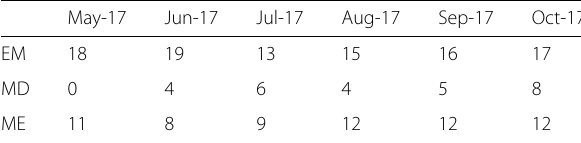
Table 7 The number of days with a cyber event